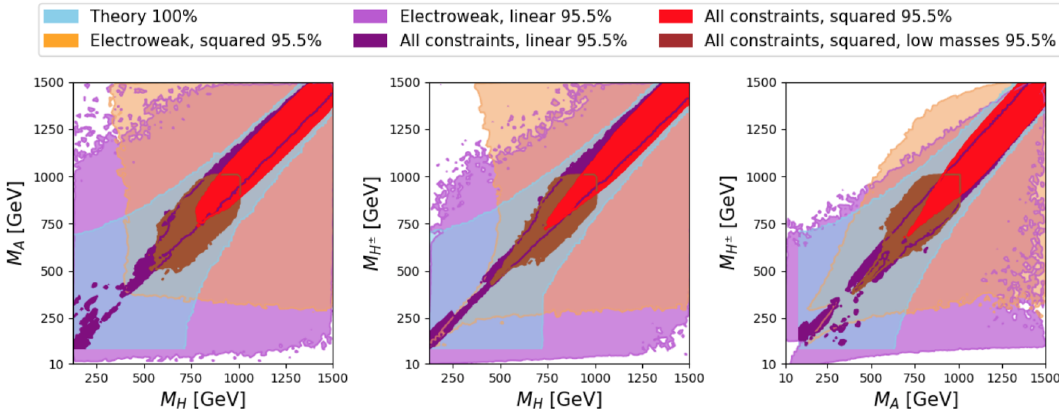
Figure 7. Allowed regions on the planes M H – M A (left), M H – M (right) from theoretical constraints at 100% probability (blue), from EWPOs at 95.5% probability (in orange, squared mass priors and in light purple, linear priors), and combining all constraints at 95.5% probability (linear mass priors in purple, squared mass priors in red and squared mass priors with lower masses in brown). The “All constraints” regions contain only the right-sign branch solution to the Higgs signal strengths discussed in section